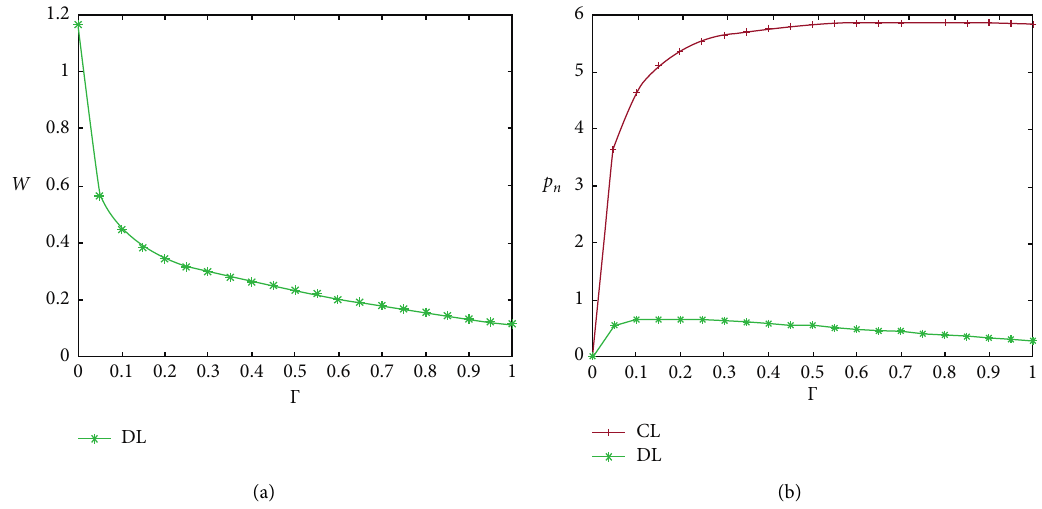
Figure 3: Effect of consumer heterogeneity on the wholesale and retail